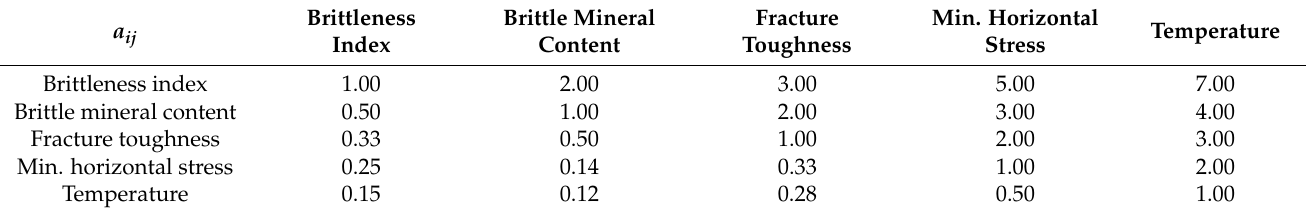
Table 3. Judgment matrix A = of the influencing